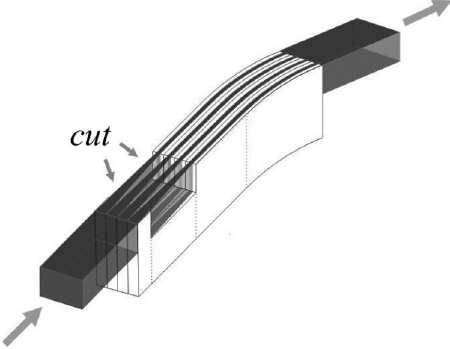
FIG. 11. A bent crystal with a cut. FIG. 12. Beam phase space at the first crystal